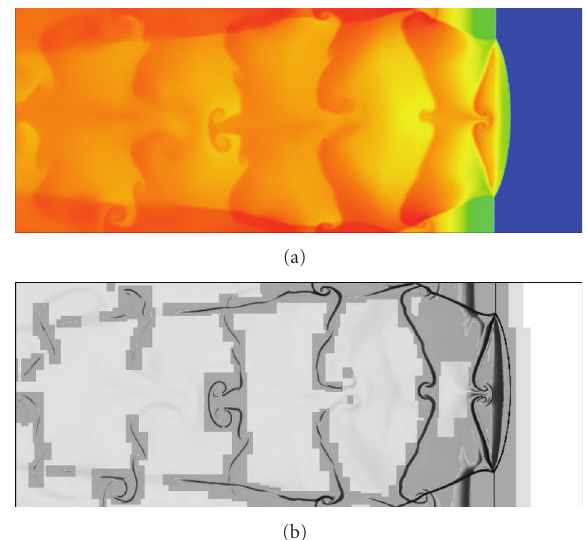
Figure 11: Color plot of temperature and schlieren plot of density on refinement in 1st half of a detonation cell.